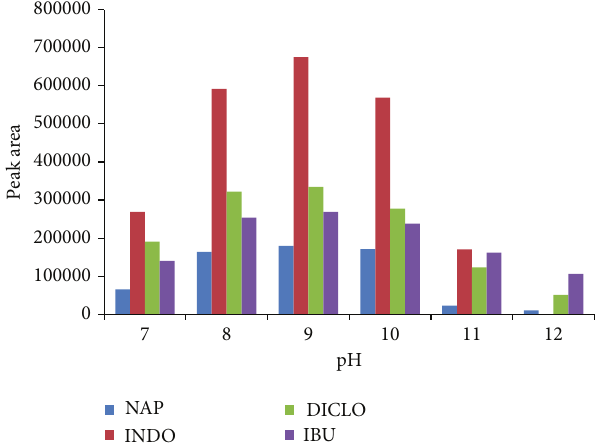
Figure 2: Adsorption efficiency of CTAB-coated MNP s as a func- tion of samples